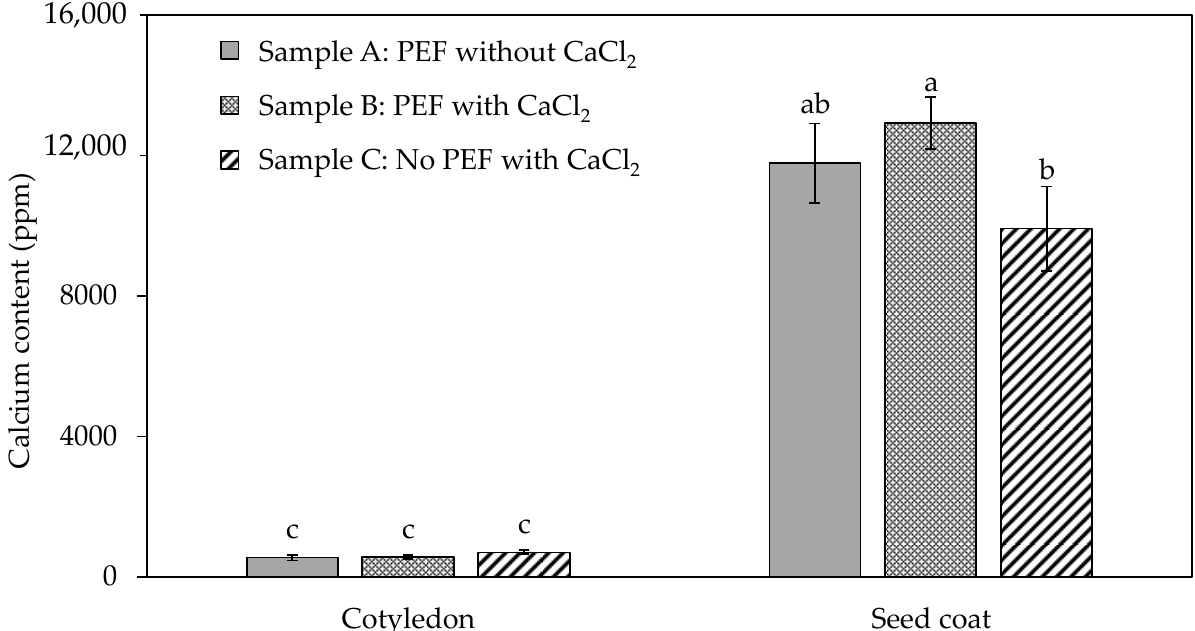
Figure 2. Calcium content of the cotyledon and seed coat of black bean samples A (PEF and thermally processed without CaCl 2 addition), B (PEF and thermally processed with CaCl 2 addition), and C (No PEF, thermally processed with CaCl 2 ). Data presented as mean ± standard deviation of three independent batches of cooked black beans ( n = 3). Values with different letters between sample type for each seed component are significantly different ( p < 0.05).